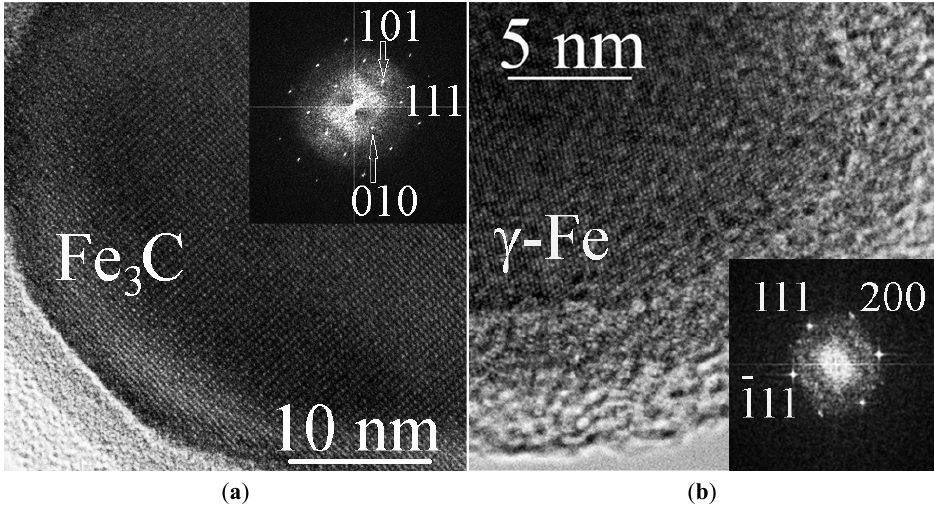
Figure 4. Fe ‐ containing carbon nanocapsules: ( a ) general TEM view manifesting mean particle size 15–30 nm; ( b ) detailed structure of a nanocapsule by TEM (arrows indicate two encapsulating shells: inner Fe 2 O 3 shell and outer carbon shell); ( c ) EDS spectra from view ( a ).